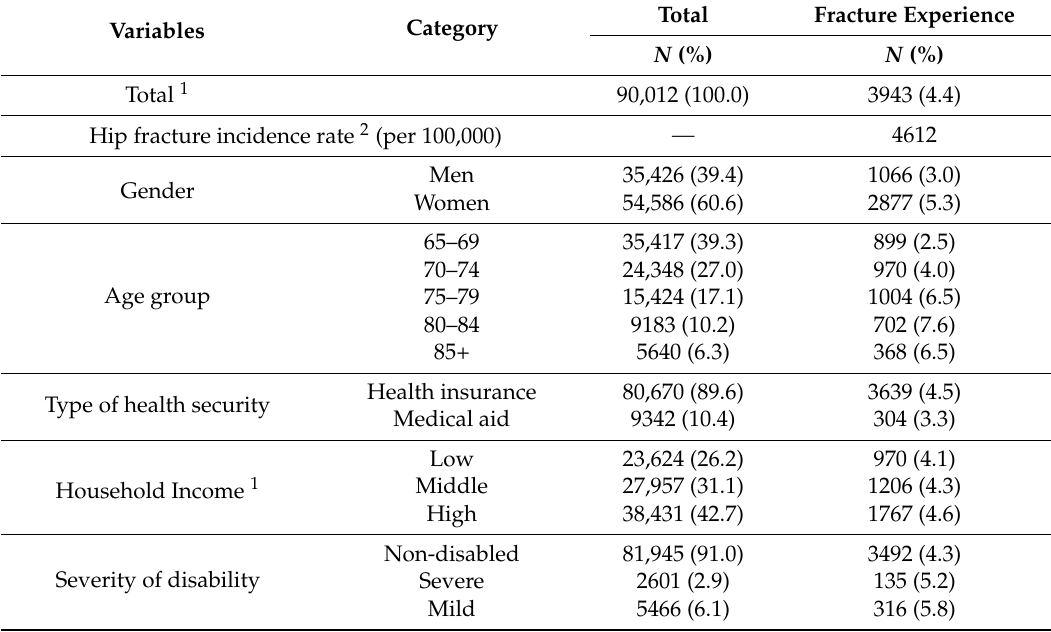
Table 1. General characteristics of the study participants in baseline National Health